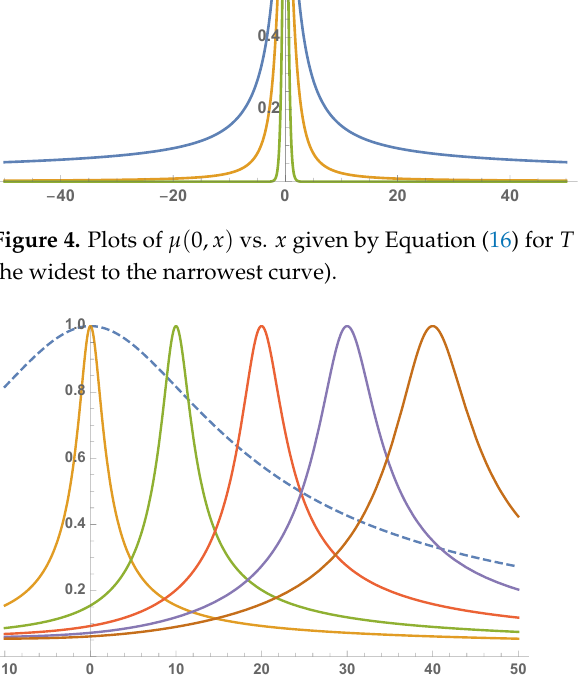
Figure 5. The same as Figure 2, but for the CSD in Equation (14), with ν =